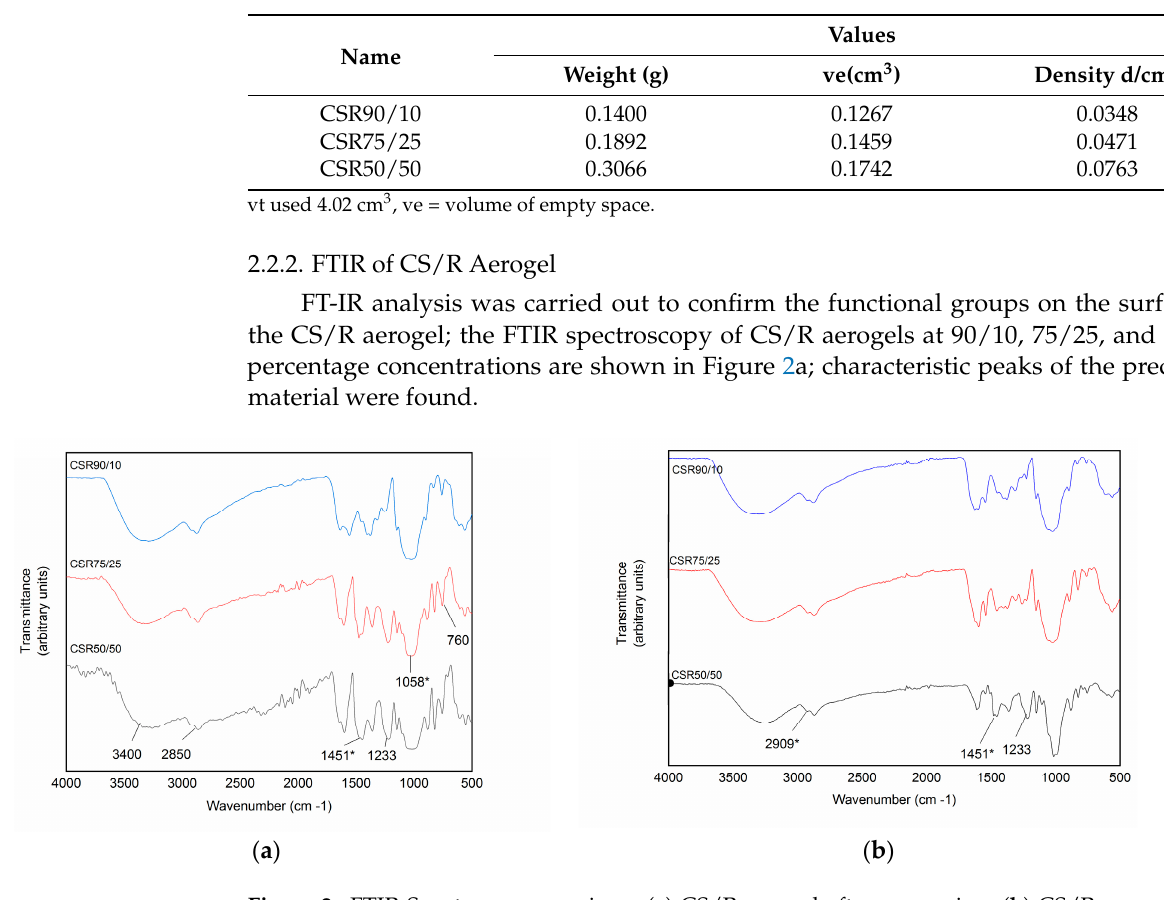
Table 2. Volume and density of CS/R aerogels.